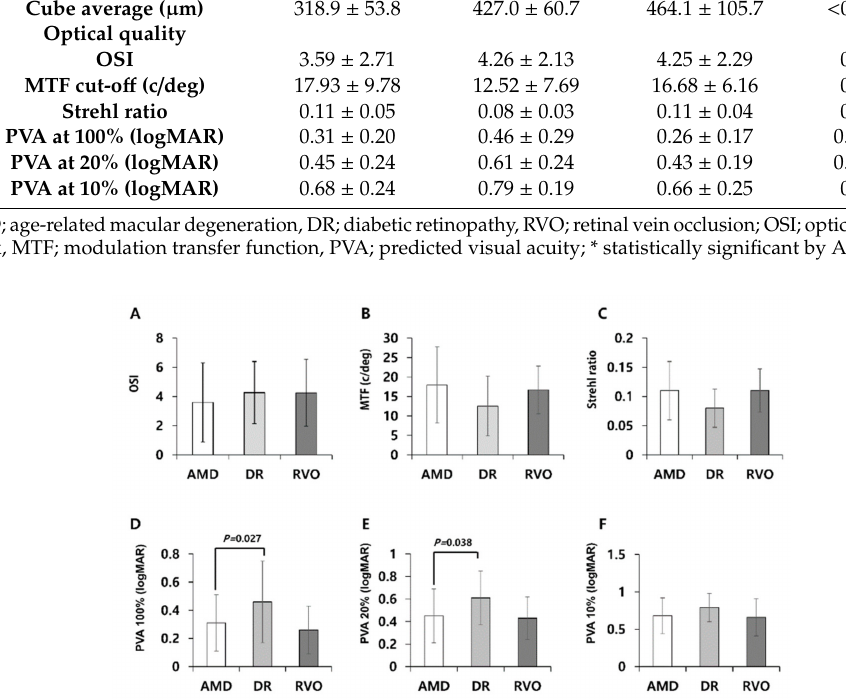
Figure 4. Comparison among subgroups of age-related macular degeneration (AMD), diabetic retinopathy with macular edema (DR), and retinal vein occlusion with macular edema (RVO). D, E . Compared to the AMD subgroup, the DR subgroup had higher mean predicted visual acuities (PVA) at 100% and 20% contrast levels. A, B, C, F . OSI, MTF, Strehl ratio, or PVA at 10% contrast did not showed significant inter-subgroup di ff erences. P-value is presented if it is significant by Bonferroni post hoc test. Error bars represent standard deviation